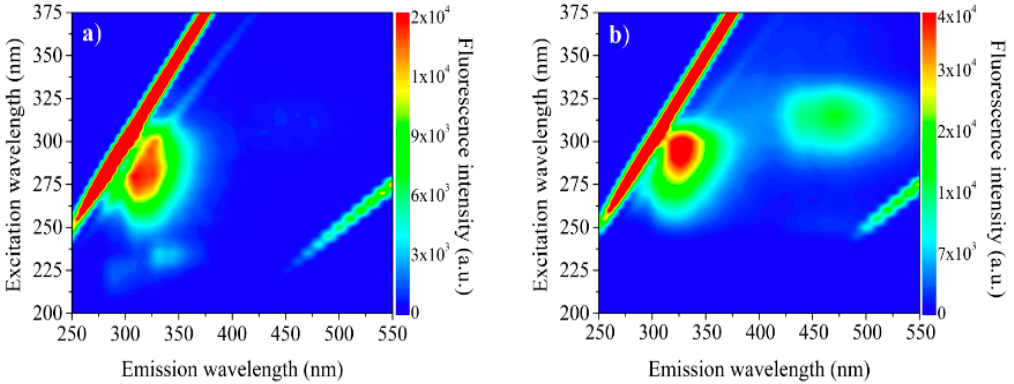
Figure 6. Excitation-emission map of oils from the babassu obtained by exciting between 200–375 nm and emission in the 250–550 nm range (concentration: ( a ) 1 × 10 − 3 and ( b ) 0.05 g/mL).